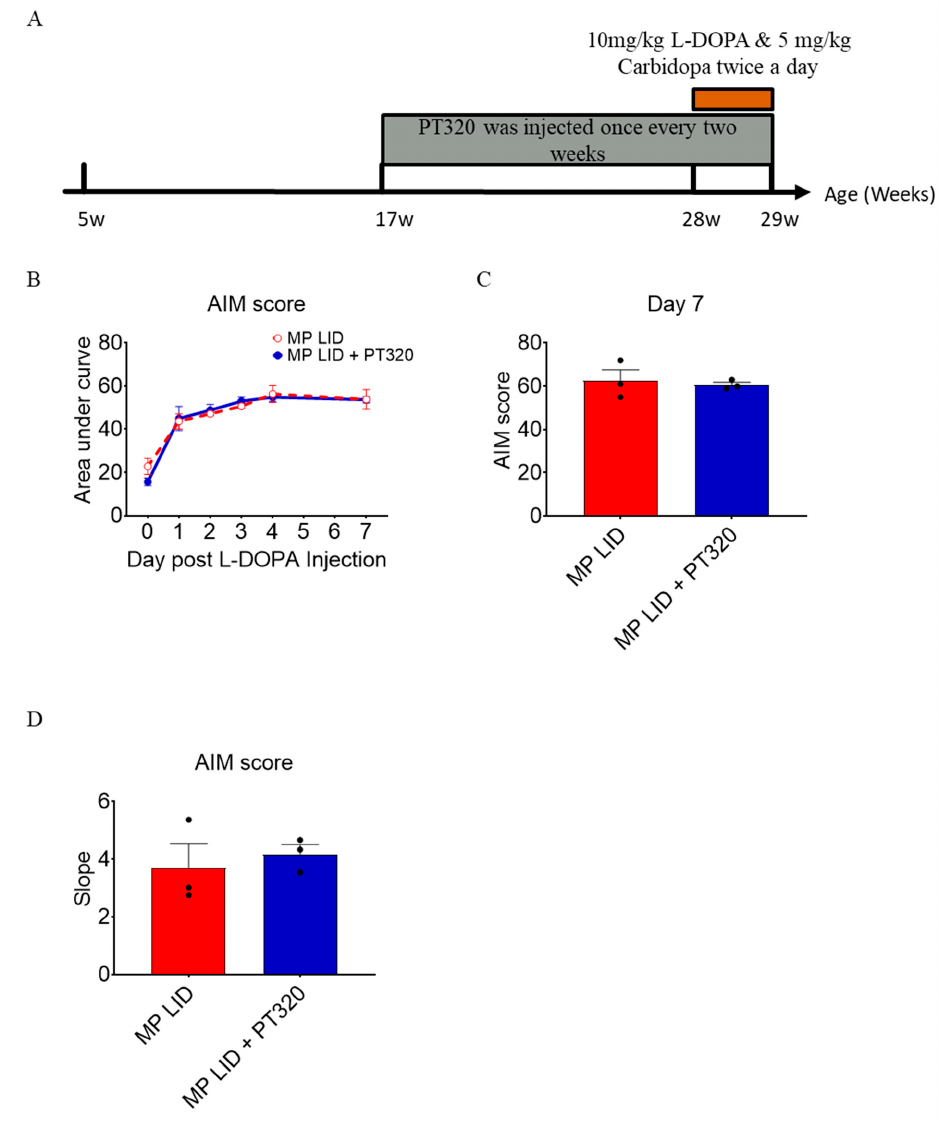
Figure 6. In the late treatment group, PT320 was administered to MP mice beginning at 17 weeks of age and dyskinesia was induced with a one-week induction protocol at 28 weeks of age. ( A ) Exper- imental design: PT320 treatment in MP started at 17 weeks of age and LID was induced with a one- week protocol at 28 weeks of age. ( B ) There were no significant differences between treatment and non-treatment groups. ( C ) There were no significant differences between AIM scores on day 7. ( D ) The slope of AIM scores also revealed no significant differences between groups. There was no difference in severity of axial deviation (Figure 7A,B), extent of limb displacement (Figure 7C,D), intensity of abnormal paw movement (Figure 7G,H) or du- ration of standing (Figure 7E,F) between late PT320-treated and untreated groups.